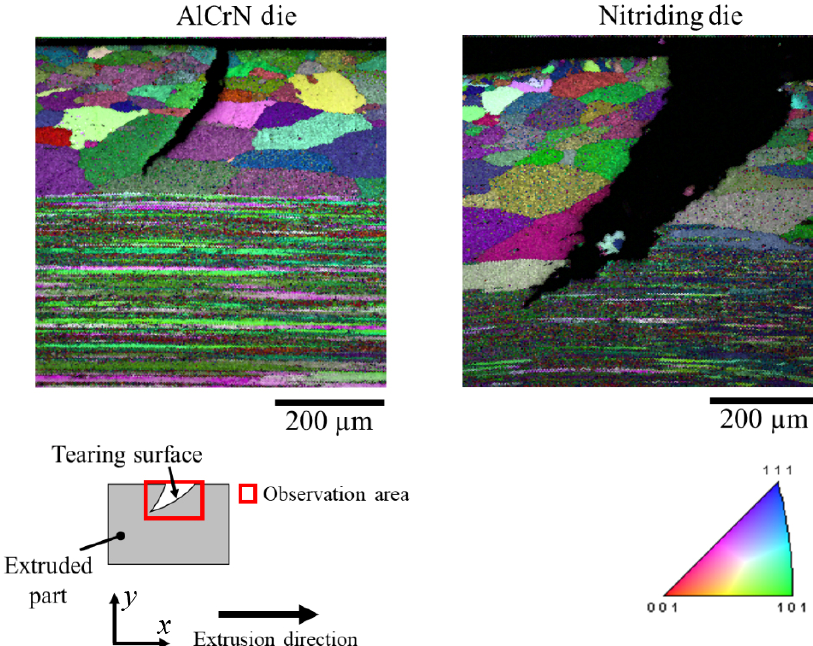
Fig. 14 Microstructure observation of the crystal orientation of the extruded material surface for AlCrN and nitriding dies by the EBSD (billet temperature: 450 °C, ram speed: 1.0